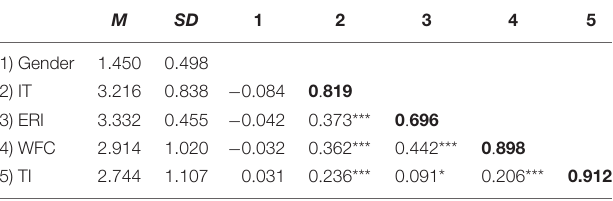
TABLE 2 | Means, standard deviations, correlations, and